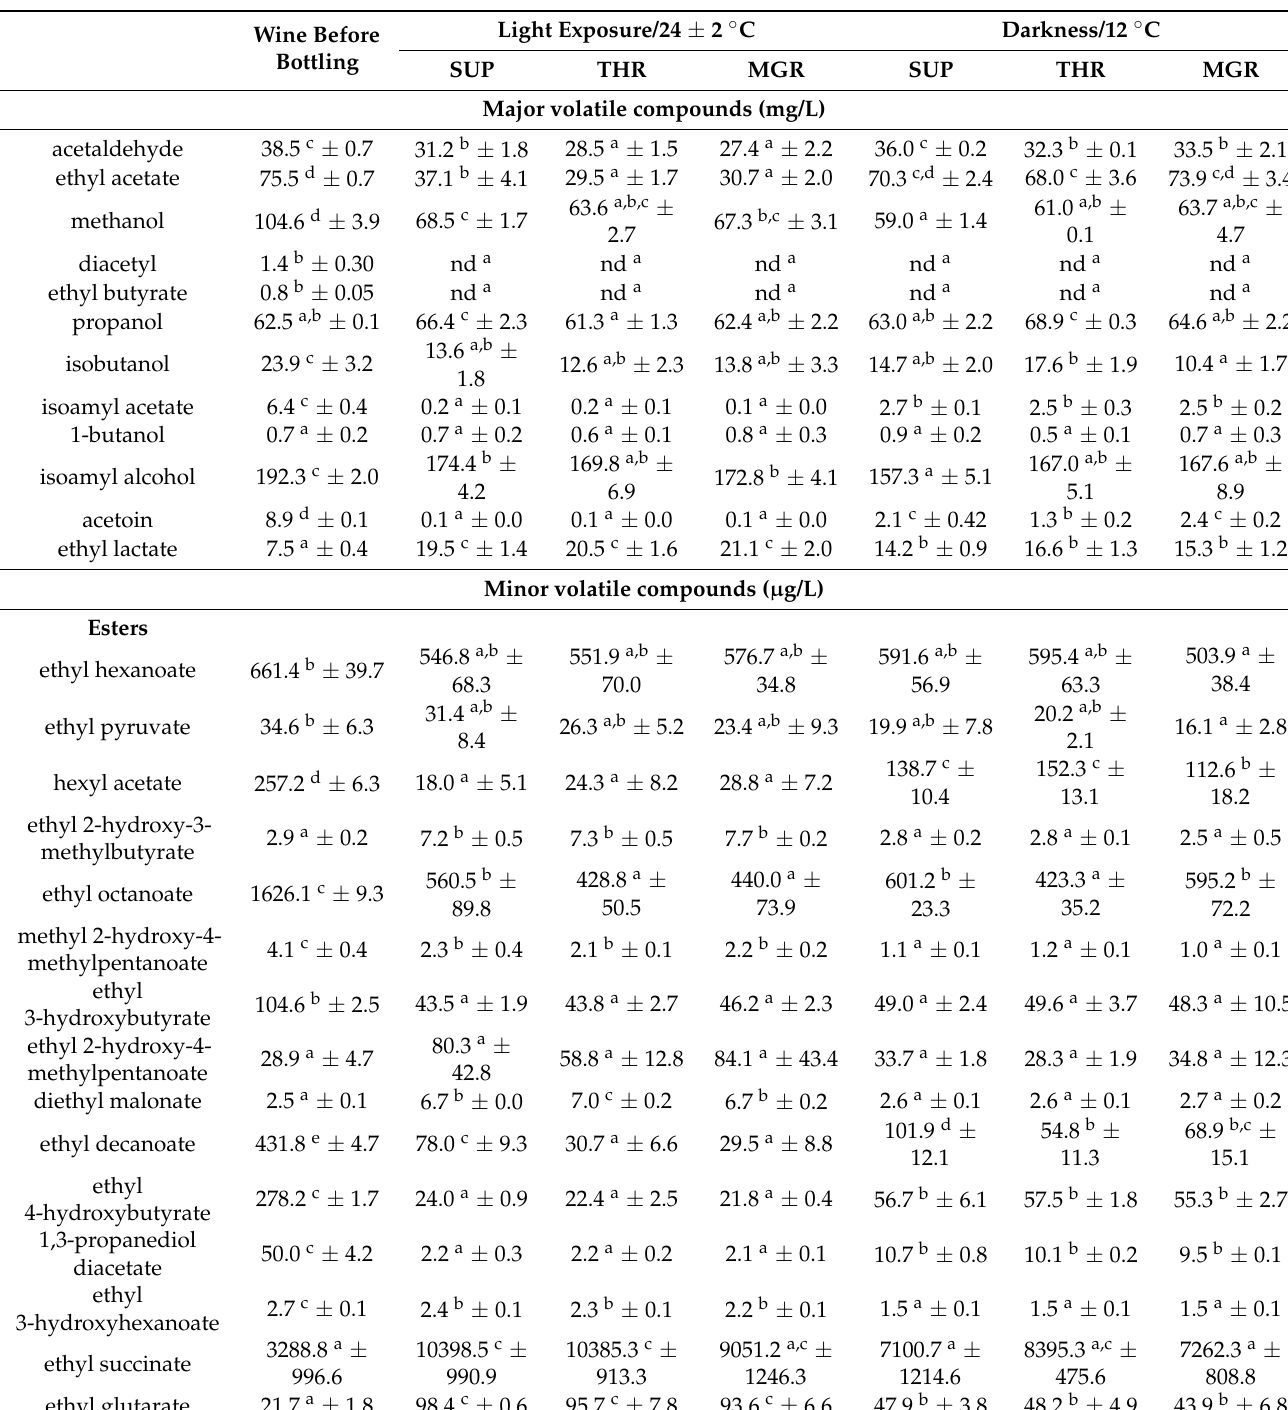
bottle-aged wines. Similar results were found in commercial white wines stored without temperature control compared to those stored at 5 ◦ C [3] and in Chardonnay wines stored at 15 ◦ C [20]. In this last study, the authors did not find any difference between the wines stored with or without light exposure. Table 3. Major (mg/L) and minor ( µ g/L) volatile compounds in wines before bottling and storage for one year under the different conditions tested. SUP: super quality natural corks; THR: third quality natural corks; MGR: microgranulated corks. Wine